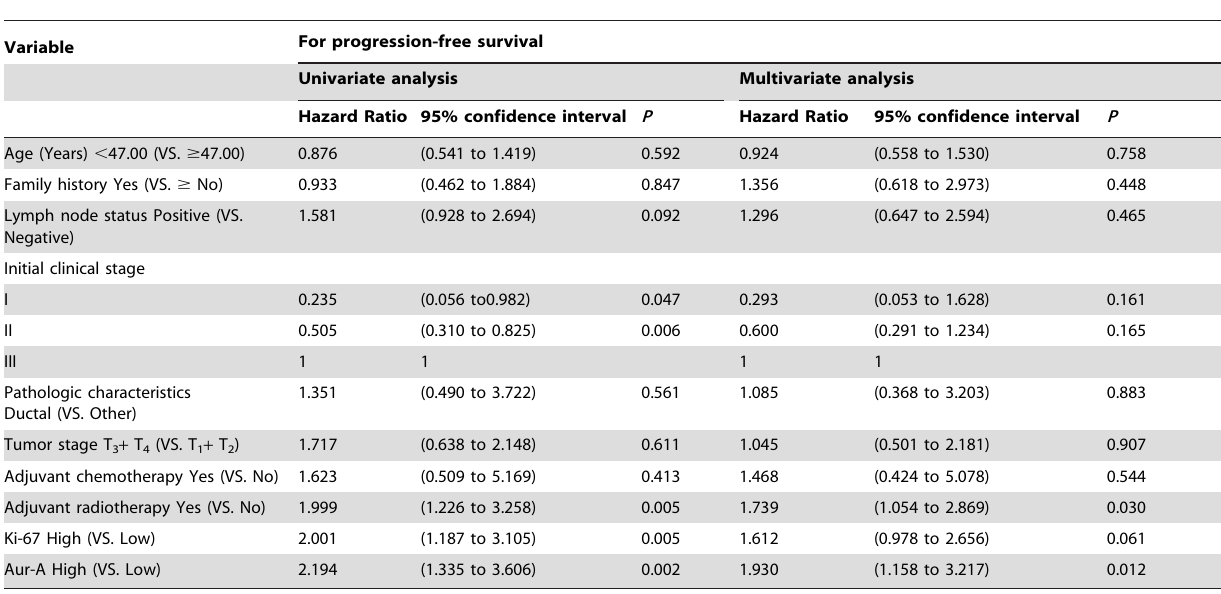
Table 4. Results of univariate and multivariate Cox proportional-hazards analysis in TNBC patients for progression-free survival